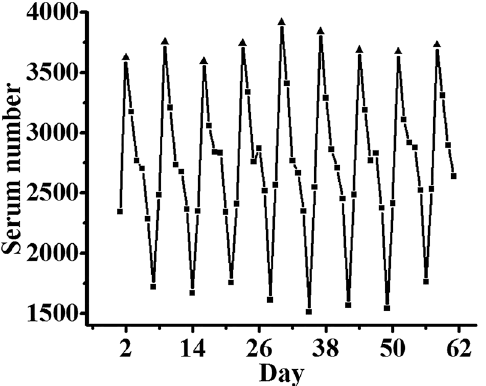
Figure 1: The tendency chart and the Tuesday effect of clinical chemistry serums in our clinical chemistry laboratory within 62 days. Our test tube number was between 300 and 800 (almost 5,000 – 15,000 clinical chemistry tests) within a week. Black triangles representtheserumnumbersonTuesdayandblacksquareswerethe other day. The tTAT and reagent-loading pattern before optimization.